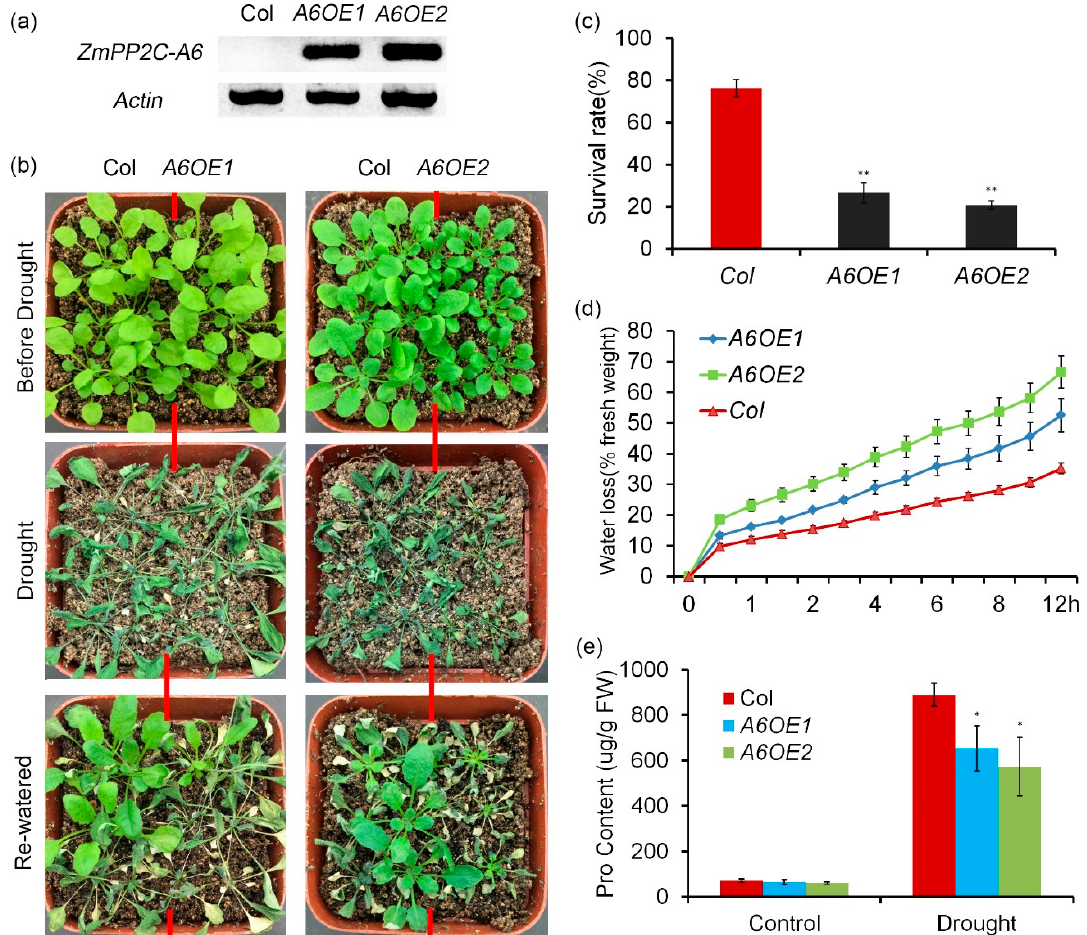
Figure 4. Overexpression of ZmPP2C-A6 in Arabidopsis decreased tolerance to drought. ( a ) RT-PCR analysis of ZmPP2C-A6 overexpression lines. ( b ) Drought tolerance assay of Col and two ZmPP2C-A6 overexpression lines. Twenty-day-old plants were drought-stressed for ten days and then re-watered for three days. ( c ) Survival rates of Col and ZmPP2C-A6 transgenic plants after drought stress. Asterisks indicate the significance of T -test, ** p < 0.01 ( d ) Water loss assay indicates that leaves from ZmPP2C-A6 transgenic plants more easily lost water after detached. ( e ) Proline contents of well-watered and drought-stressed Col and ZmPP2C-A6 transgenic plants. Asterisks indicate the significance of T -test, * p < 0.05 Data represent the mean ± SD of three replicates in ( c – e ).